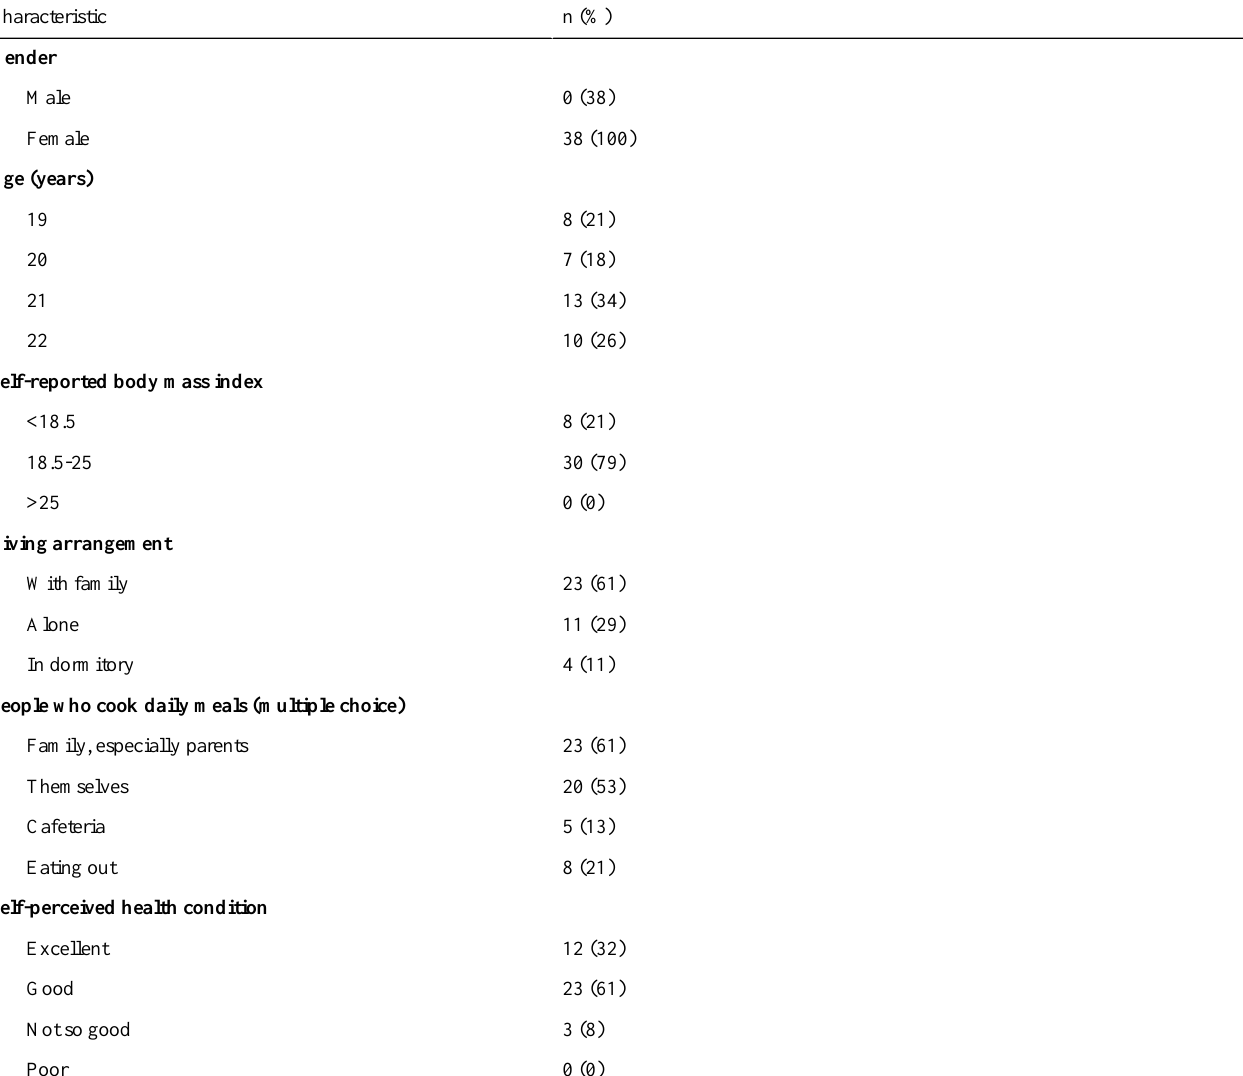
Table 1. Basic characteristics of participants